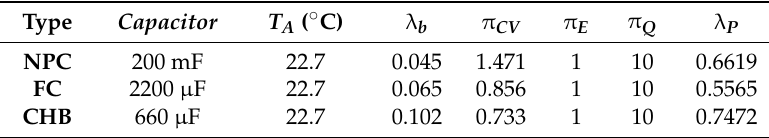
Table 6. The calculated base failure rate of capacitors.